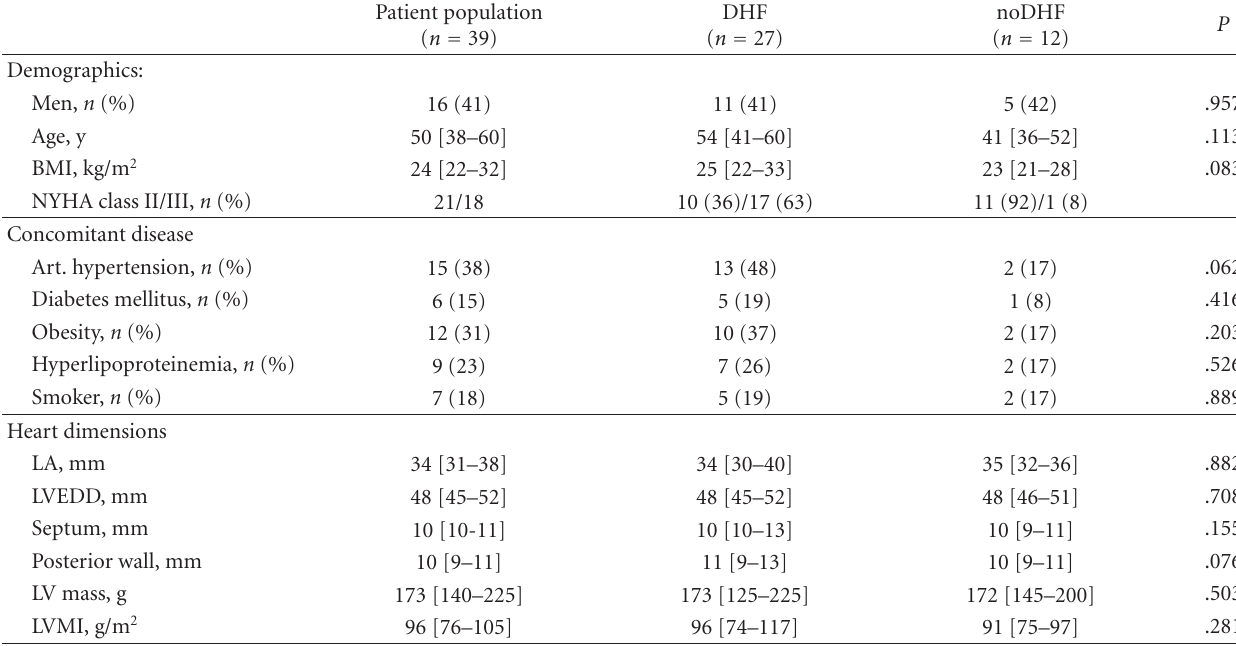
Table 1: Patient Characteristics (variable expressed as median [25–75%